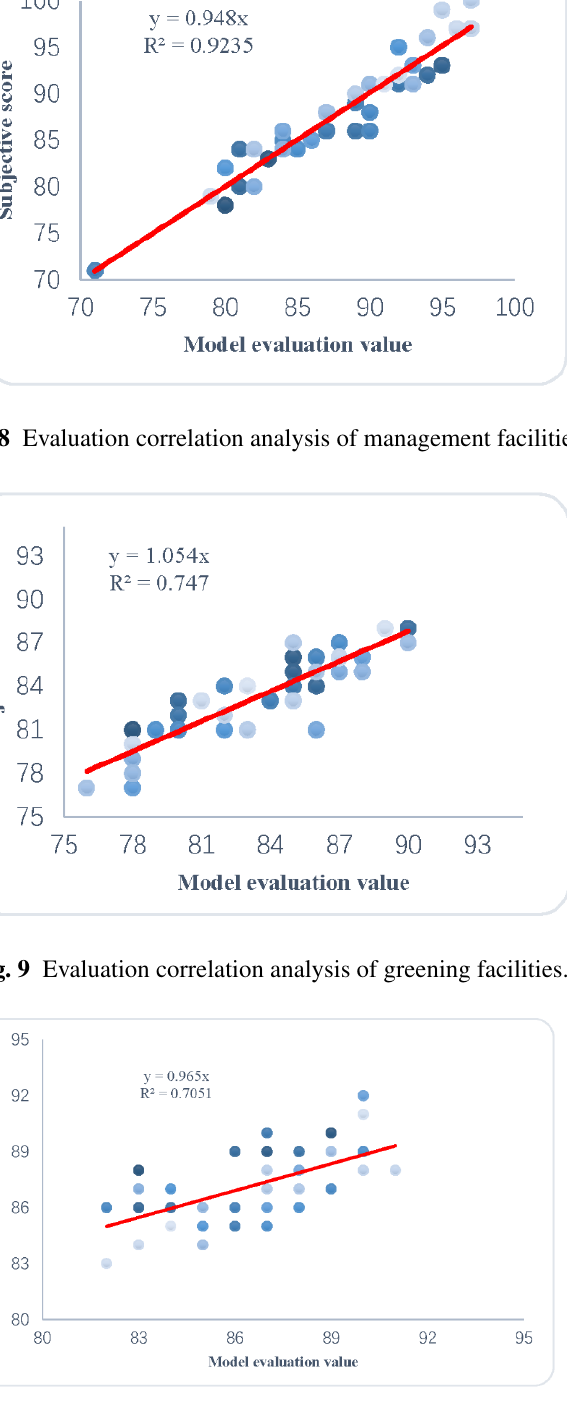
Fig. 10 Correlation analysis of comprehensive evaluation of road safety